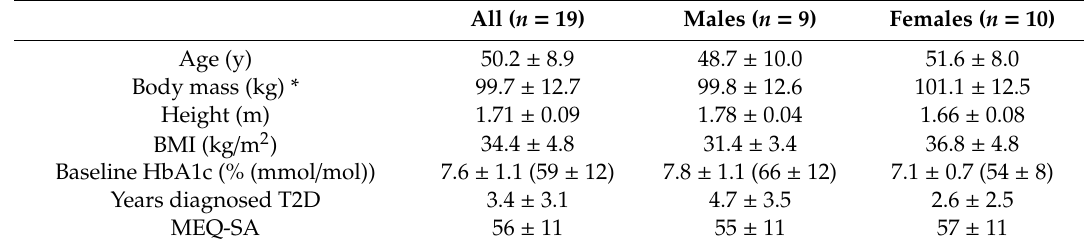
Table 1. Participant characteristics of participants with type 2 diabetes who completed the study.